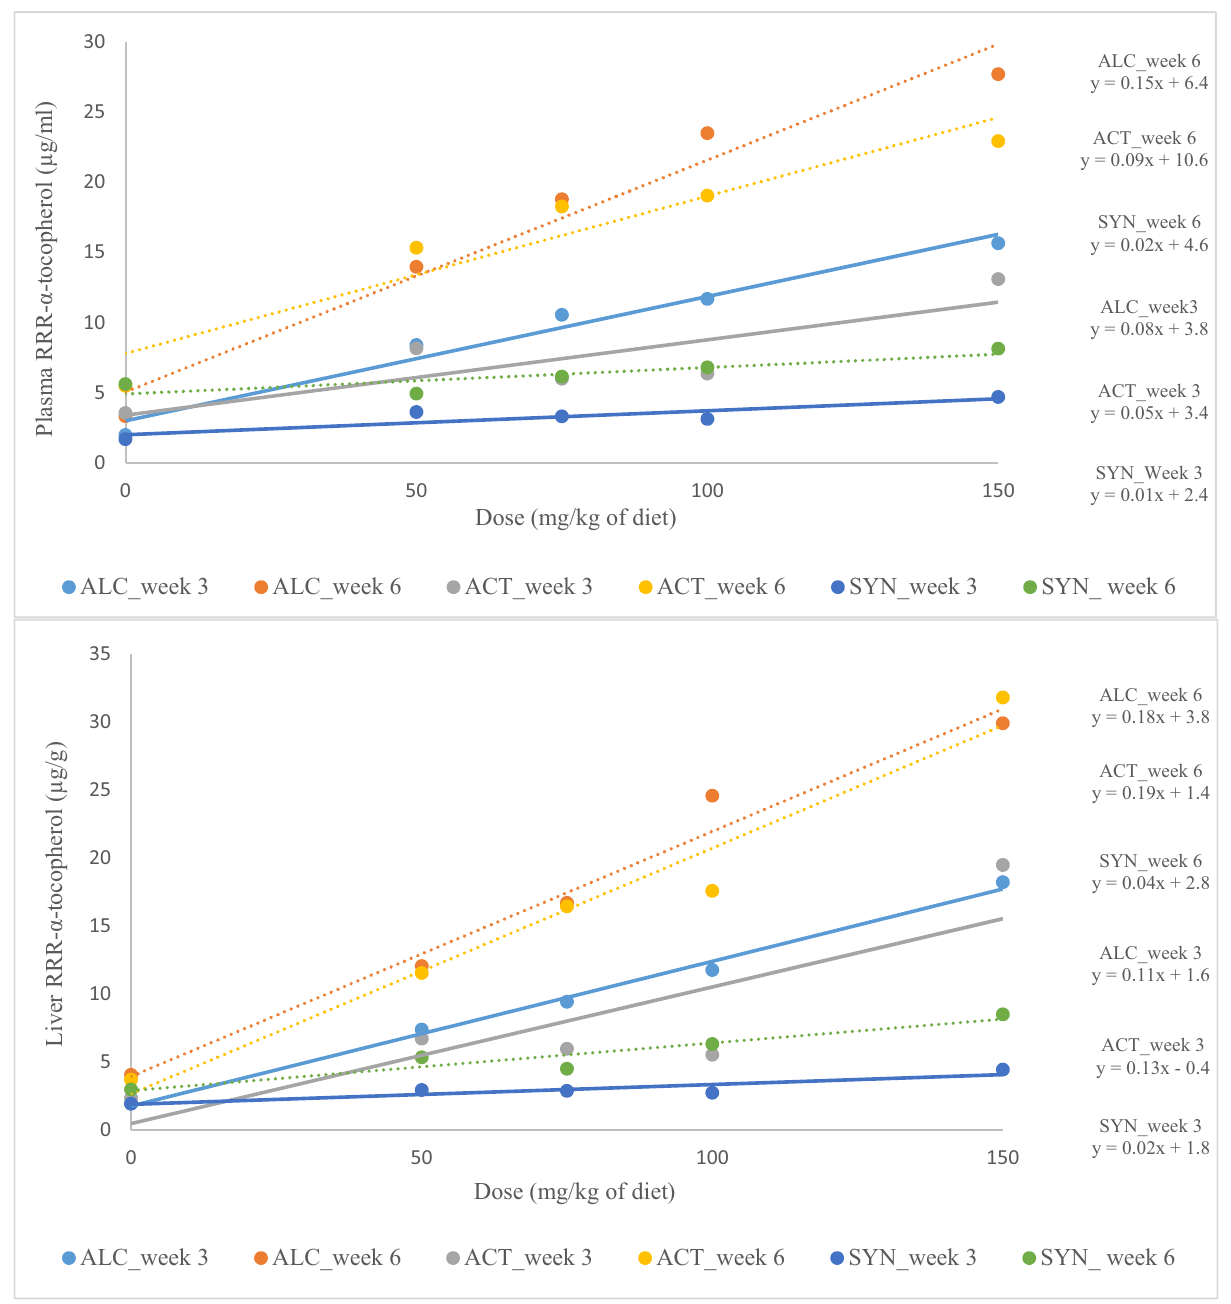
Figure 3. Linear correlation in plasma, liver, heart and lungs between the RRR-α-tocopherol and dose of supplementation in mink kits fed diets supplemented with RRR-α-tocopherol after 6 weeks (ALC_week 6) and 3 weeks (ALC_week 3), RRR-α-tocopheryl acetate after 6 weeks (ACT_week 6) and 3 weeks (ACT_week 3) and all-rac -α-tocopheryl acetate after 6 weeks (SYN_week 6) and 3 weeks (SYN_week 3). Solid line and dashed line represent the LS-means for weeks 3 and 6,